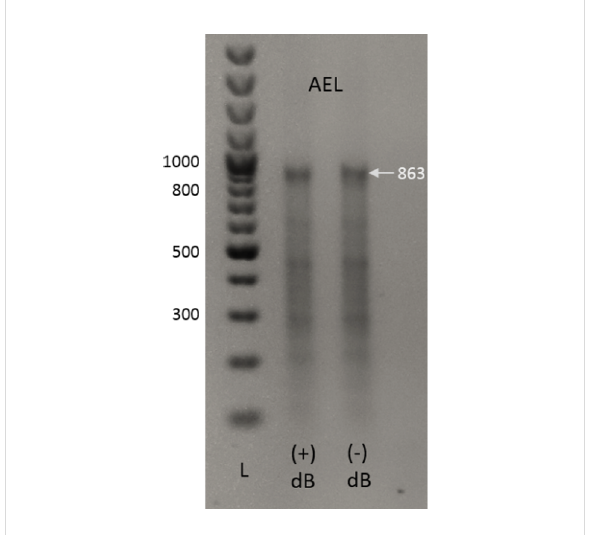
Figure 5: Agarose gel (1%, stained with ethidium bromide) showing the products (before PCR) arising from the autonomous assembly of the AEGIS-containing oligonucleotide fragments (Figure 4) for a gene encoding kanamycin resistance (863 base pairs) under two incubation conditions (#1, same method as in text with 2’-d-isoGTP (d B TP) included in the mixture; #2 as in text). Left lane (L) is a ladder with markers indicated at 300, 500, 800, and 1,000 nucleotides. Remark- ably, a principal product runs at 863 nucleotides, the length of the complete construct arising from the autonomous assembly of 20 frag- ments. When similar autonomous assembly without AEGIS nucleotides is attempted, the desired full-length product is almost never seen as a principal product, and almost never recovered without